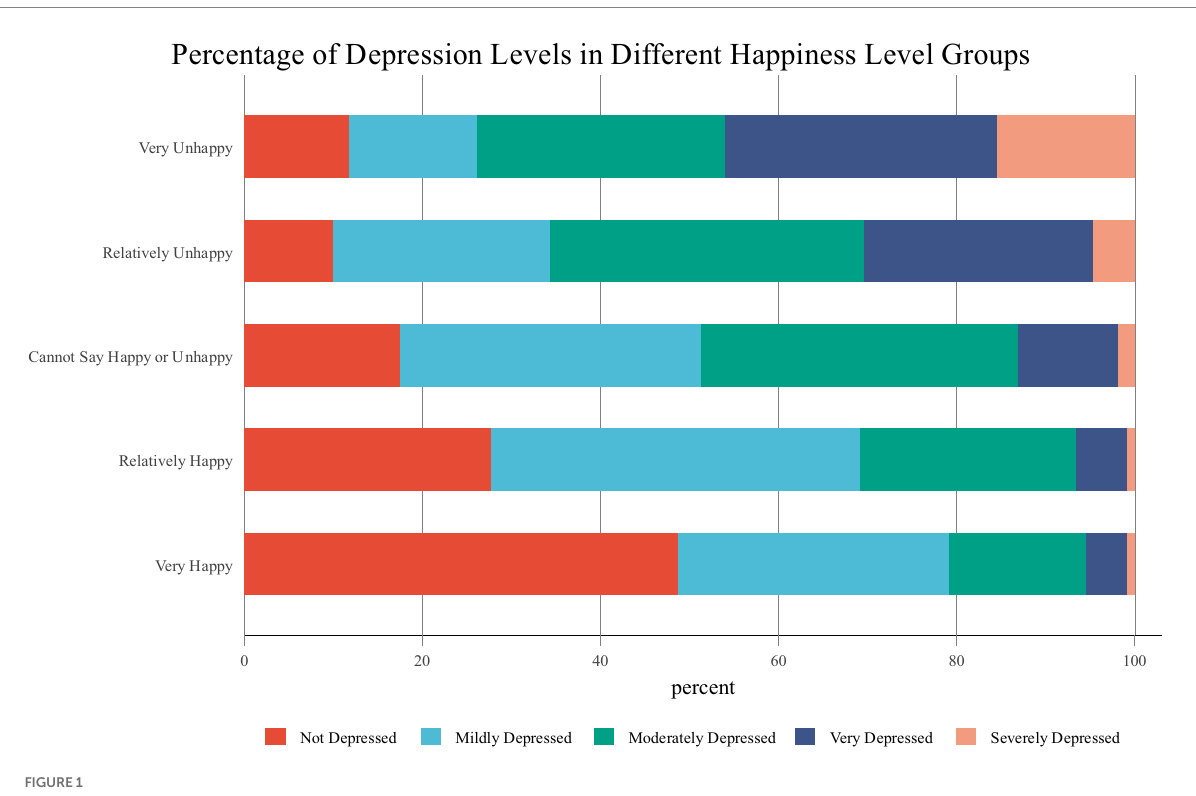
FIGURE 1 Relationship between subjective well-being and perceived depressive